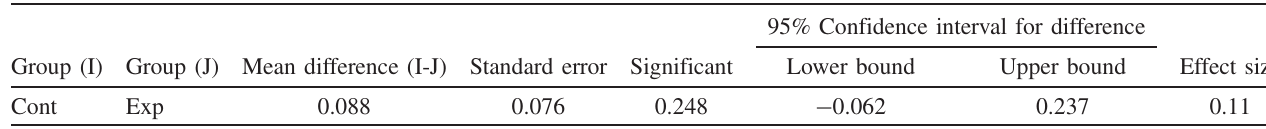
TABLE VII. A pairwise comparison of the variance of pre-post gains between the experimental group and the control group for the source of knowledge authority factor.